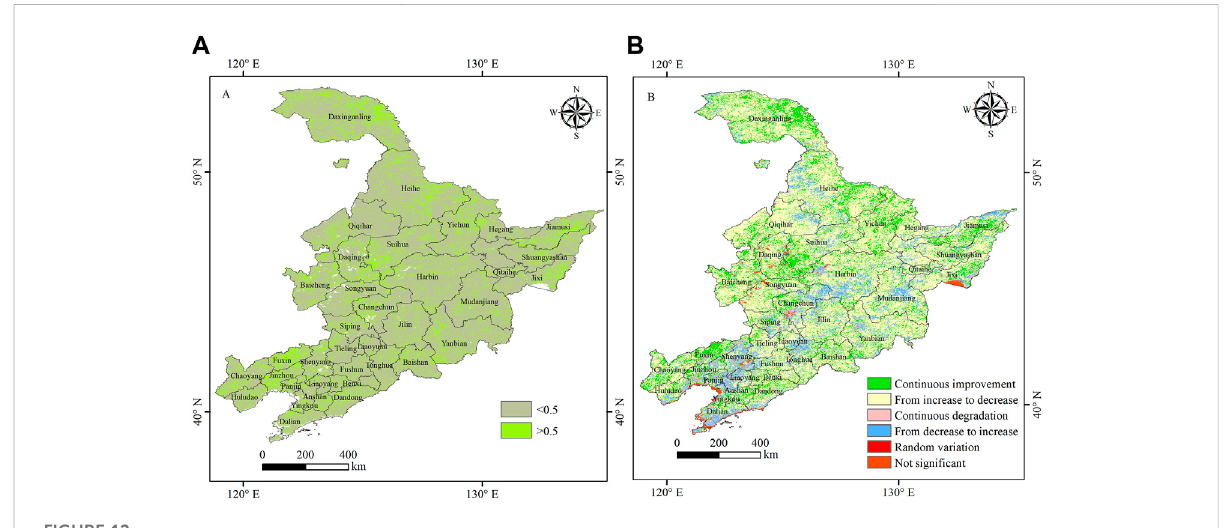
FIGURE 12 NDVI Hurst index and future trend of the three northeast provinces (A,B)